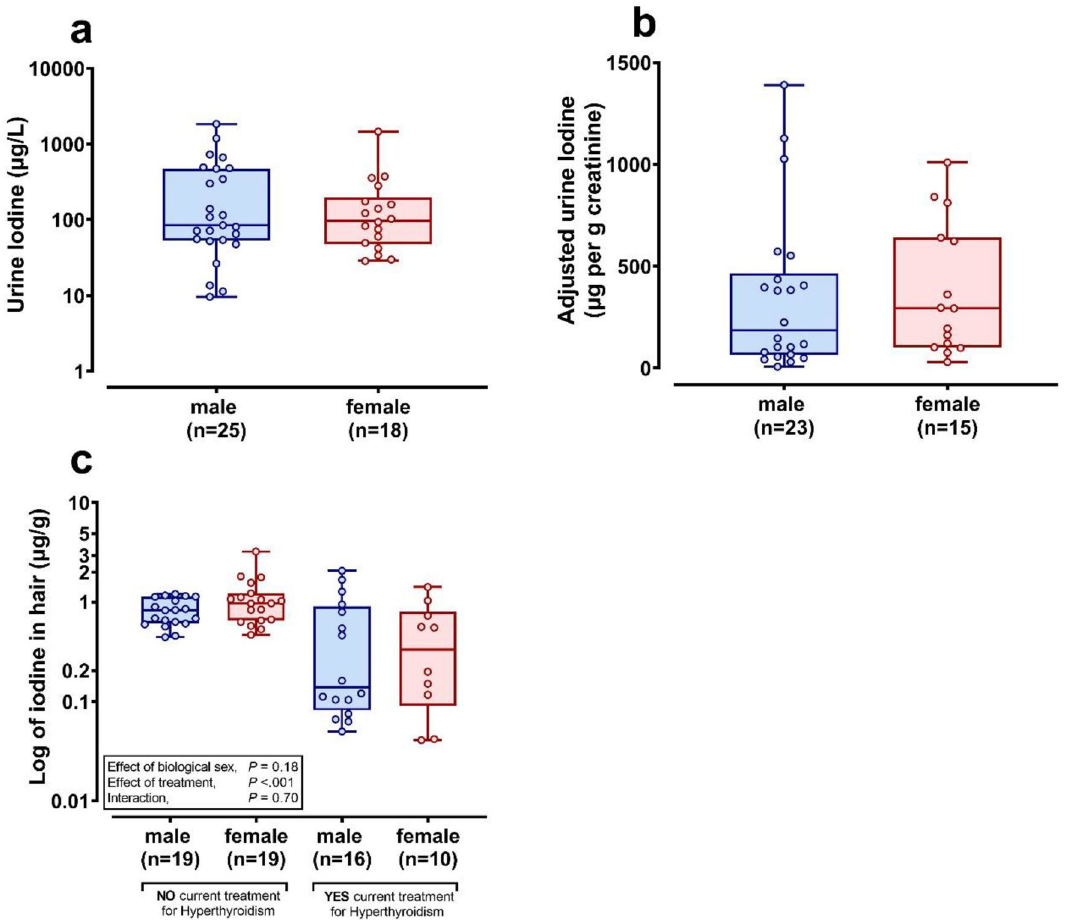
Figure 4. Iodine content of domestic cat urine and hair. ( a) Iodine concentration was measured in neat urine samples (500 μl) from cats, diluted 1-in-20 with 1% TMAH using ICP-MS. ( b) Data adjusted to urine creatinine concentration, to control for variation in urine flow. Log10-transformed data are presented as box and whisker plots on a semi-logarithmic scale (a) , y-axis), where boxes indicate the median, lower and upper quartiles and whiskers extend to min and max values. ( c) Iodine in cat hair. Hair was washed consecutively with 3:1 (v/v) ethyl-ether:acetone, 5% EDTA for 1 h, then purite water (three-times), dried at 50 °C for 48 h. Washed and dried hair samples (100-200 mg) were digested with TMAH and iodine content determined in a 1% TMAH matrix using ICP-MS. Data were log10-transformed to normalise the distribution prior to statistical analysis using ANOVA for effect of sex, treatment for hyperthyroidism or their interaction. Statistical significance was accepted at P <